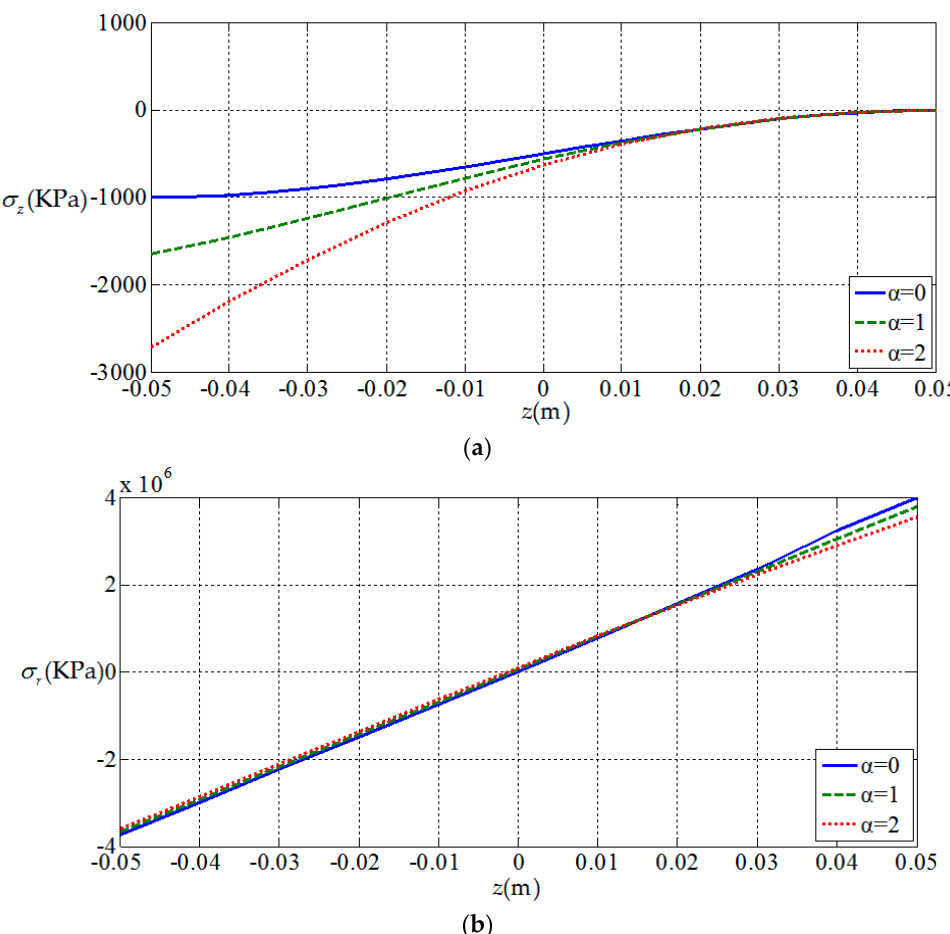
Figure 7. Variation of elastic stress with coordinates z . ( a ) z -direction stress at the periphery of plate σ z ( 1, z ) ; ( b ) radial stress at the periphery of plate σ r ( 1, z ) .